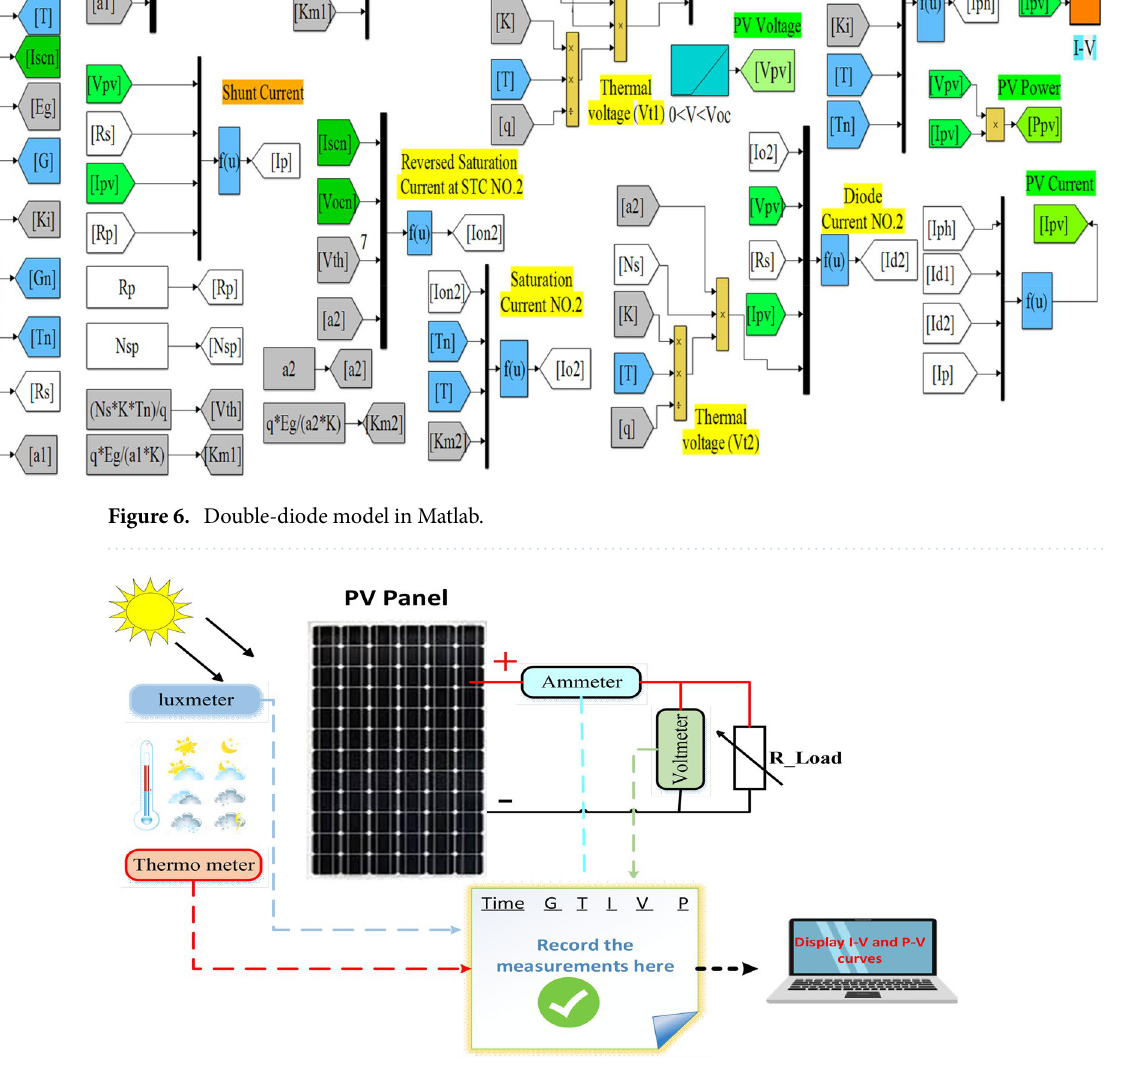
Figure 7. Proposed PV system